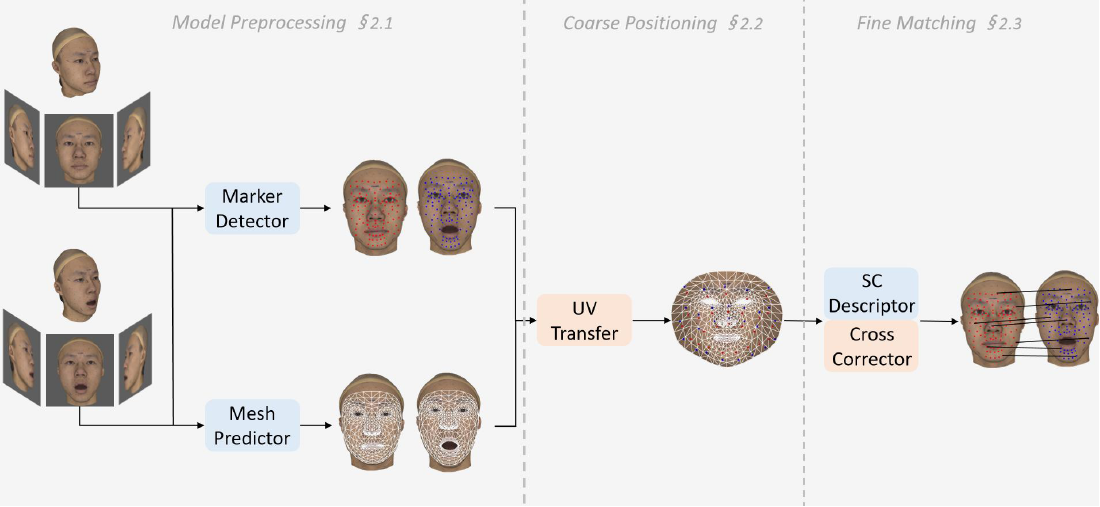
Figure 1. Overview of the proposed method.